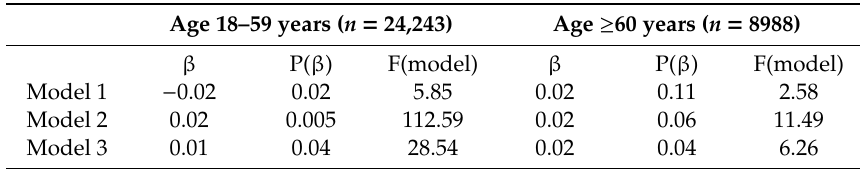
Table 2. Linear regression analysis of the age-specific association between the dietary index and oral